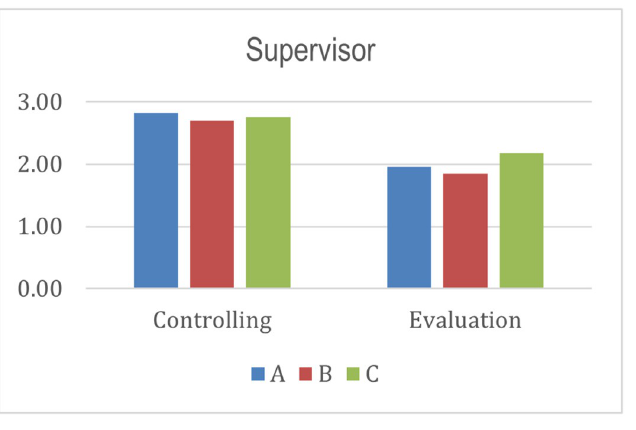
Fig 7. Index score of supervisor.